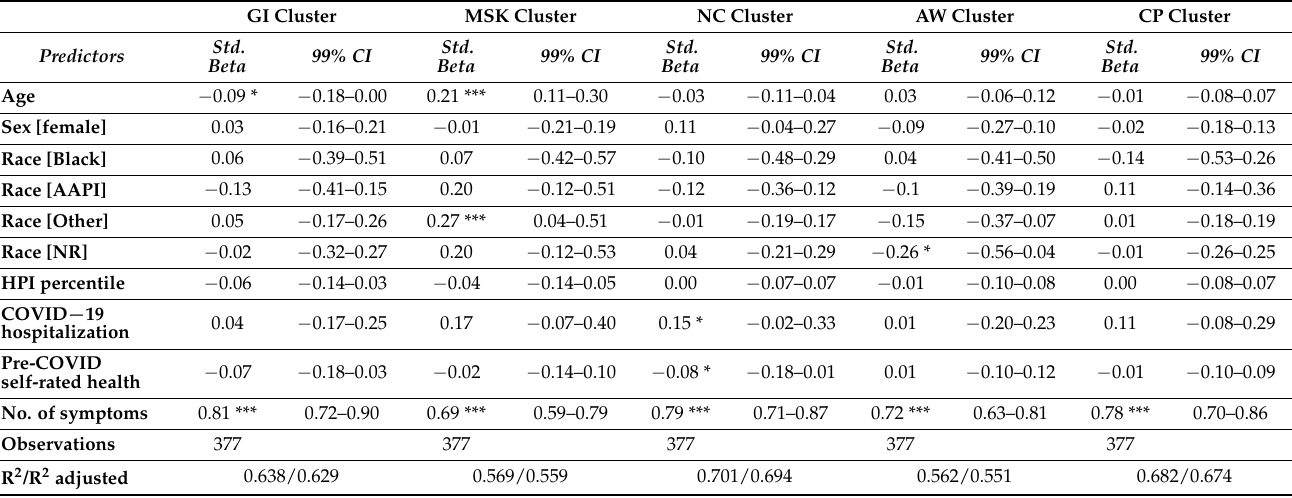
Table 2. Sociodemographic and clinical predictors of symptom clusters.